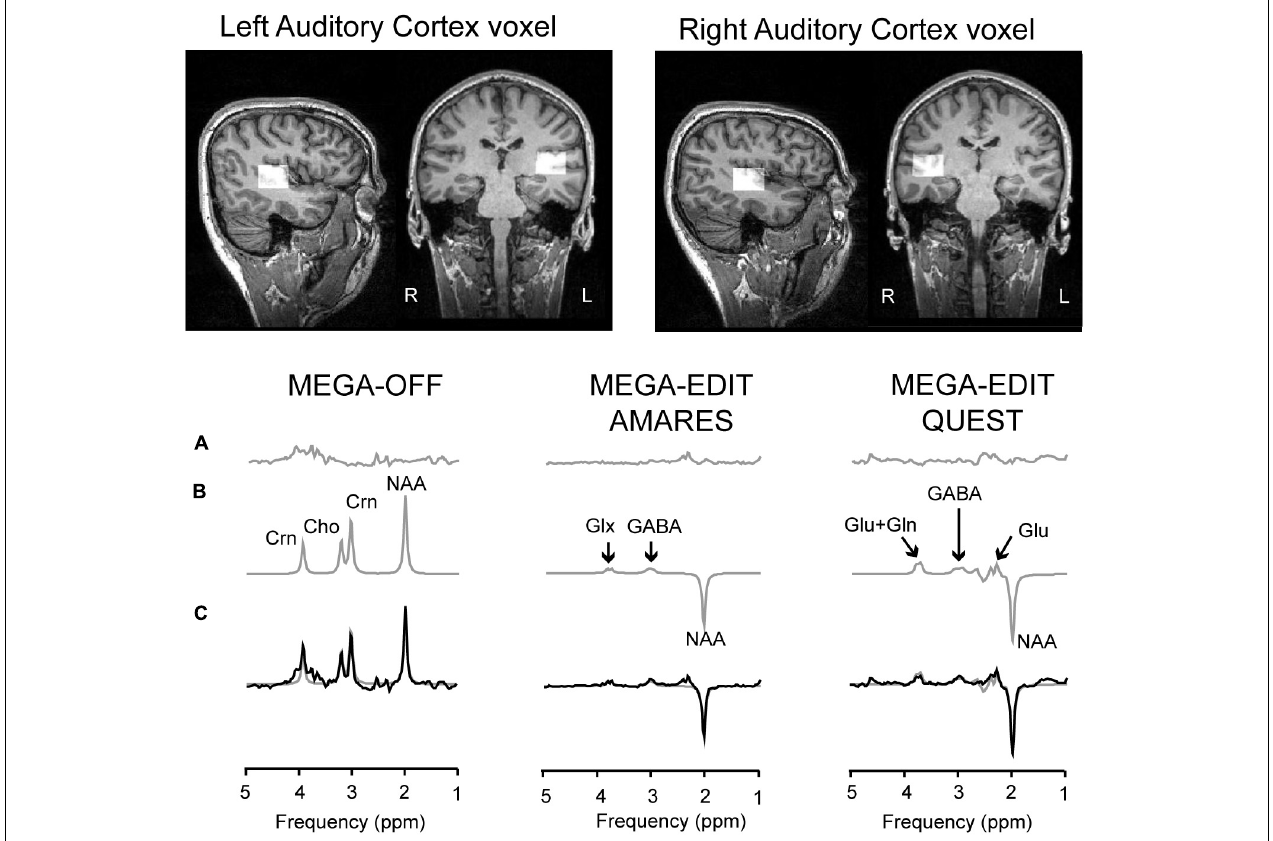
FIGURE 1 | Voxel placement and MRS analyses pipeline. Top two panels show an example of the placement of the voxels in right and left auditory cortex. The bottom-line figures show example spectra and model fits. More specifically, the bottom traces (C) show acquired data from three different subjects, with the model fit overlaid as a smooth gray line. The model fits are separately shown in panel (B) , with the residuals shown in the top traces (A) . The left-hand panel shows data from the control sub-spectrum, in which the MEGA editing pulse is set away from the GABA C3 frequency. The right-hand panels show edited spectra (subtraction of MEGA-OFF from MEGA-ON) fitted either by AMARES (middle) or QUEST/QUASAR (right). Peaks are labeled as Cho–choline–containing compounds, Crn–total creatine, GABA, glutamate–glu, glutamate plus glutamine–Glx, and